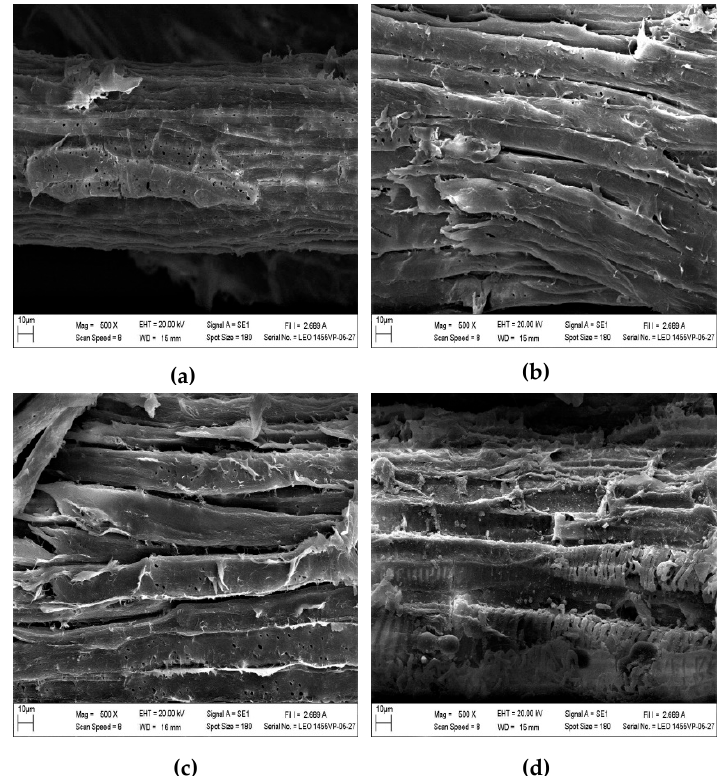
Figure 4. SEM images of the ( a ) raw and autoclave-assisted pretreated C . barbata at ( b ) 110 °C, ( c ) 120 °C, and ( d ) 130 °C.